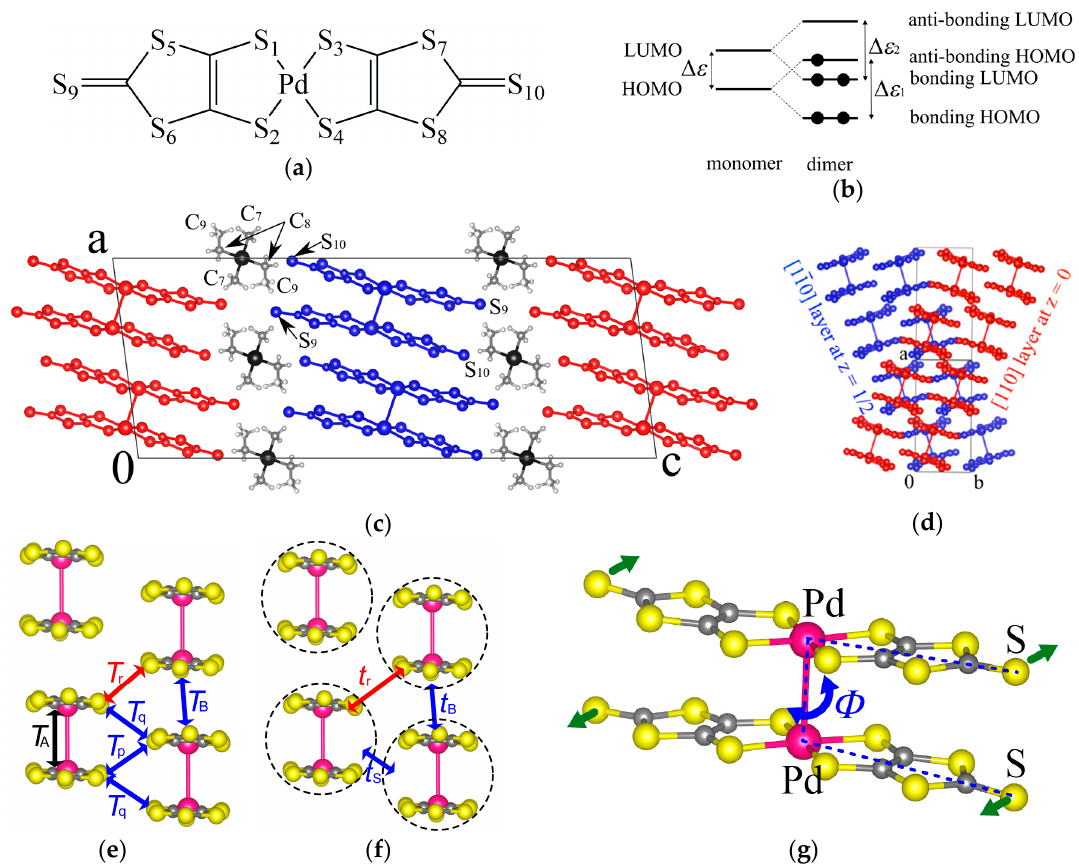
Figure 1. ( a ) Molecular structure of Pd(dmit) 2 . ( b ) Schematic illustration of orbital levels for monomer and dimer. ( c ) and ( d ) Crystal structure of β′ -EtMe 3 Sb[Pd(dmit) 2 ] 2 . End-on projections of the anion layer with notations of ( e ) intermolecular transfer integrals and ( f ) interdimer transfer integrals. ( g ) An arch-shaped distortion of the Pd(dmit) 2 molecule . The torsion angle of S–Pd–Pd–S, Φ , characterizes the degree of the distortion.